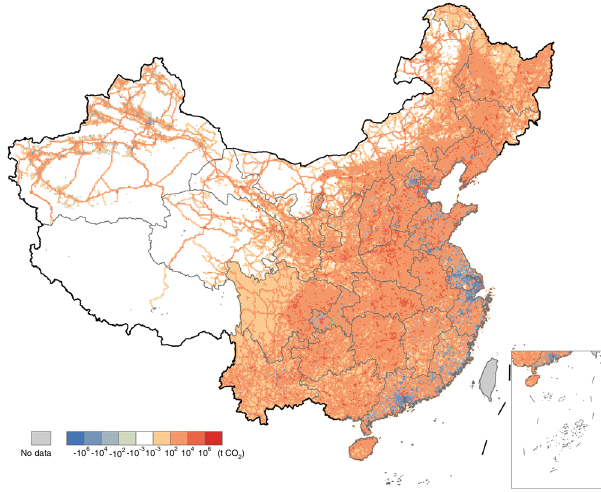
Fig. 3 Emission differences between 14.6% of the original CHRED emission map and the export-driven carbon footprint map. Blue grids mean that 14.6% of the original CHRED emissions in these grids are less than the export-driven carbon footprint, while red grids imply the